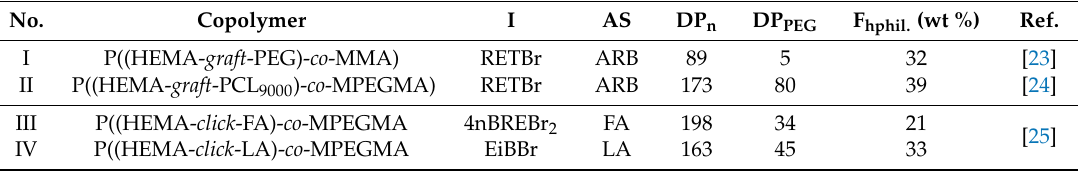
Table 2. Data for micelles (I, II) and conjugates (III, IV), amount of introduced and release active substance from the